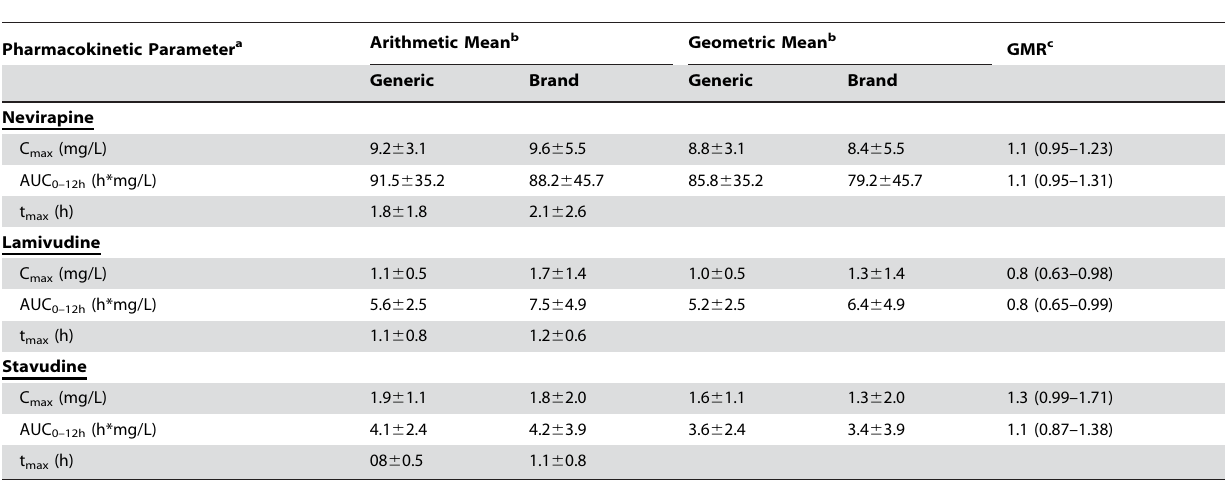
Table 3. Pharmacokinetic parameters of generic and brand name nevirapine, stavudine and lamivudine.